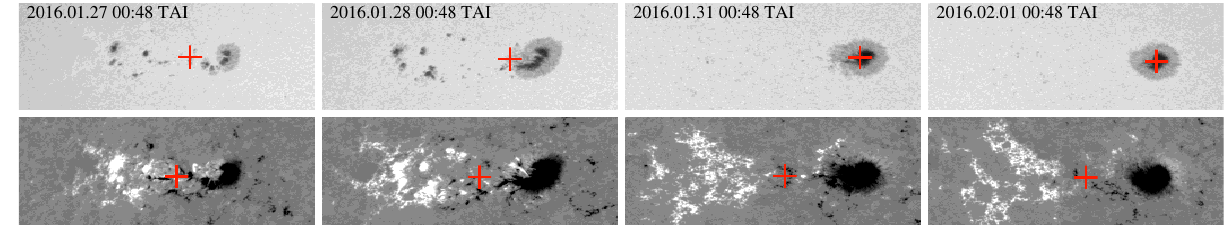
Figure 1. SDO/HMI continuum intensity images (top panels) and line-of-sight magnetograms (bottom panels) of NOAA active region 12489. The time of observations are shown in the top panels. Red crosses in the top panels mark the intensity-weighted center of the active region. Red crosses in the bottom panels denote the geometrical center of the active region (see text). The field-of-view is 260”×130”. The magnetograms are scaled from −500 Mx cm −2 (black) to 500 Mx cm −2 (white). A clear shift of the intensity-weighted center with time is seen in the top